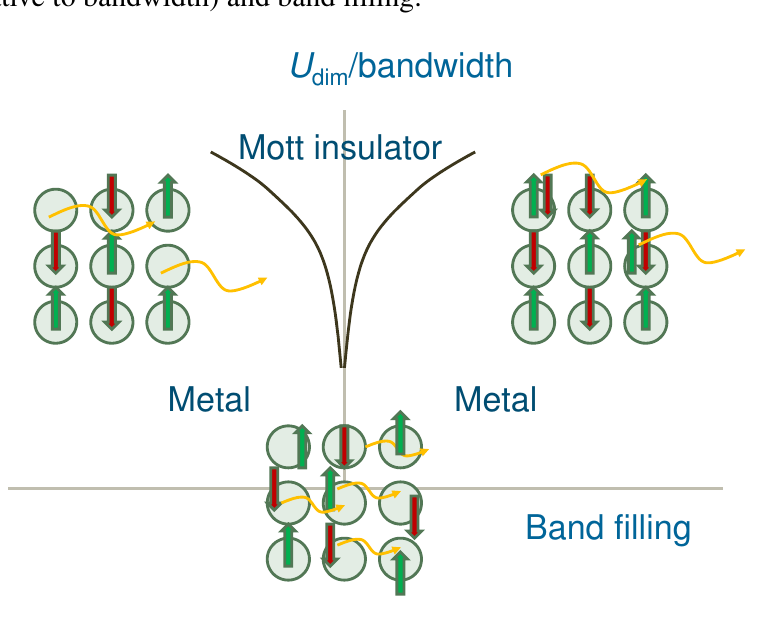
Figure 9. Schematic diagram of Mott insulator and metal phases spanned by effective on-site repulsion (relative to bandwidth) and band